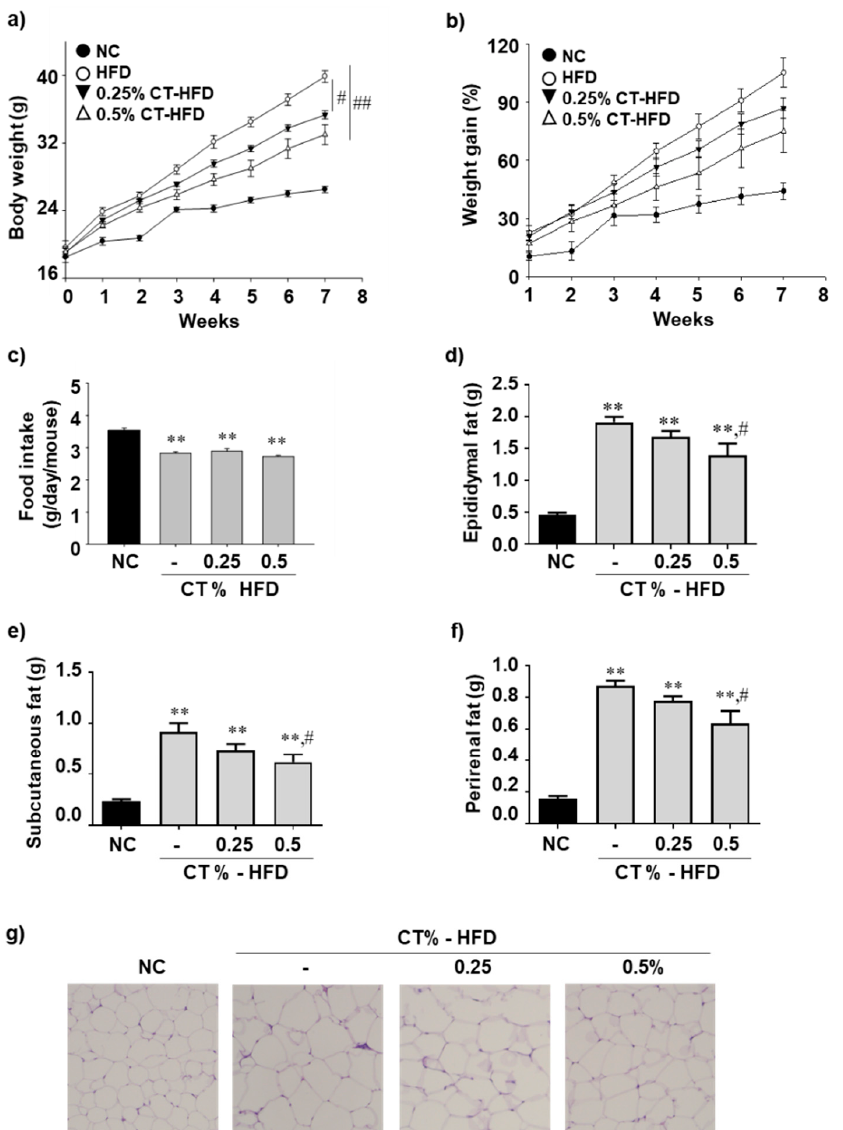
Figure 1. Effect of CT treatment on body weight, fatty tissue mass, and adipose tissue